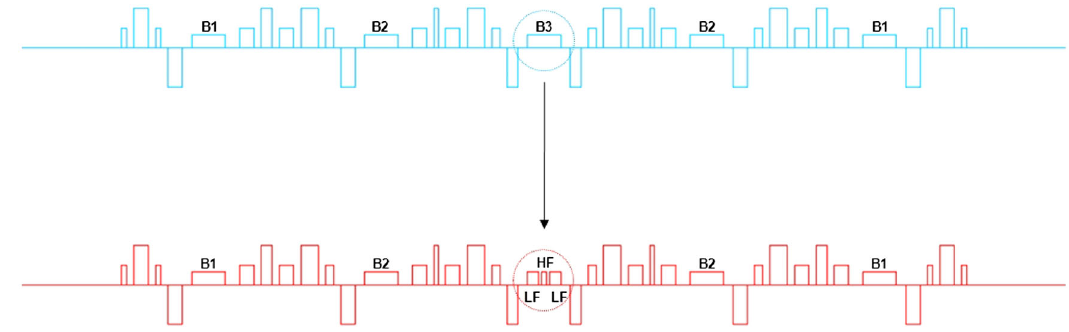
FIG. 13. The high field dipole magnet is sandwiched between two low field dipoles to radiate high energy super bright photons. This combination in the red lattice is remarked inside a dashed circle while the blue lattice represents the bare low field lattice. It should be noted that B1, B2 and B3 are the same in the